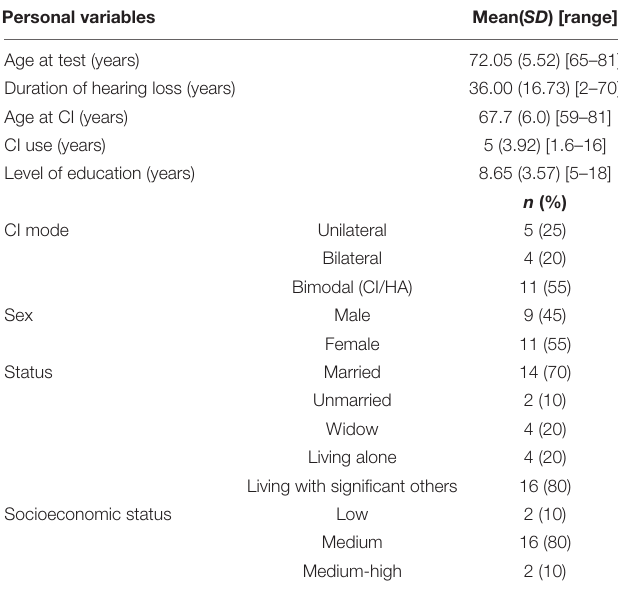
TABLE 2 | Descriptive data of the participants ( n =